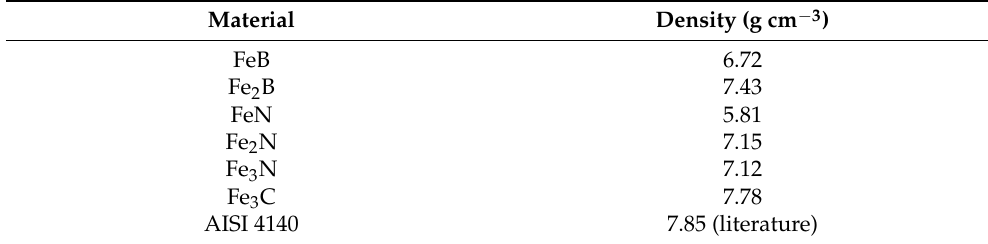
Table 5. The density of the corresponding hardening surface according to Gloker’s model